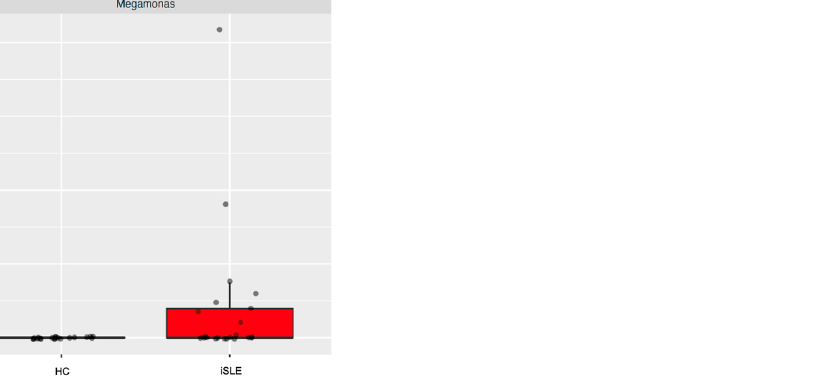
Figure 2. Relative abundance (%) of Megamonas in healthy control (HC; n = 20) versus inactive systemic lupus erythematosus (iSLE; n = 22). Statistical significance p < 0.05.